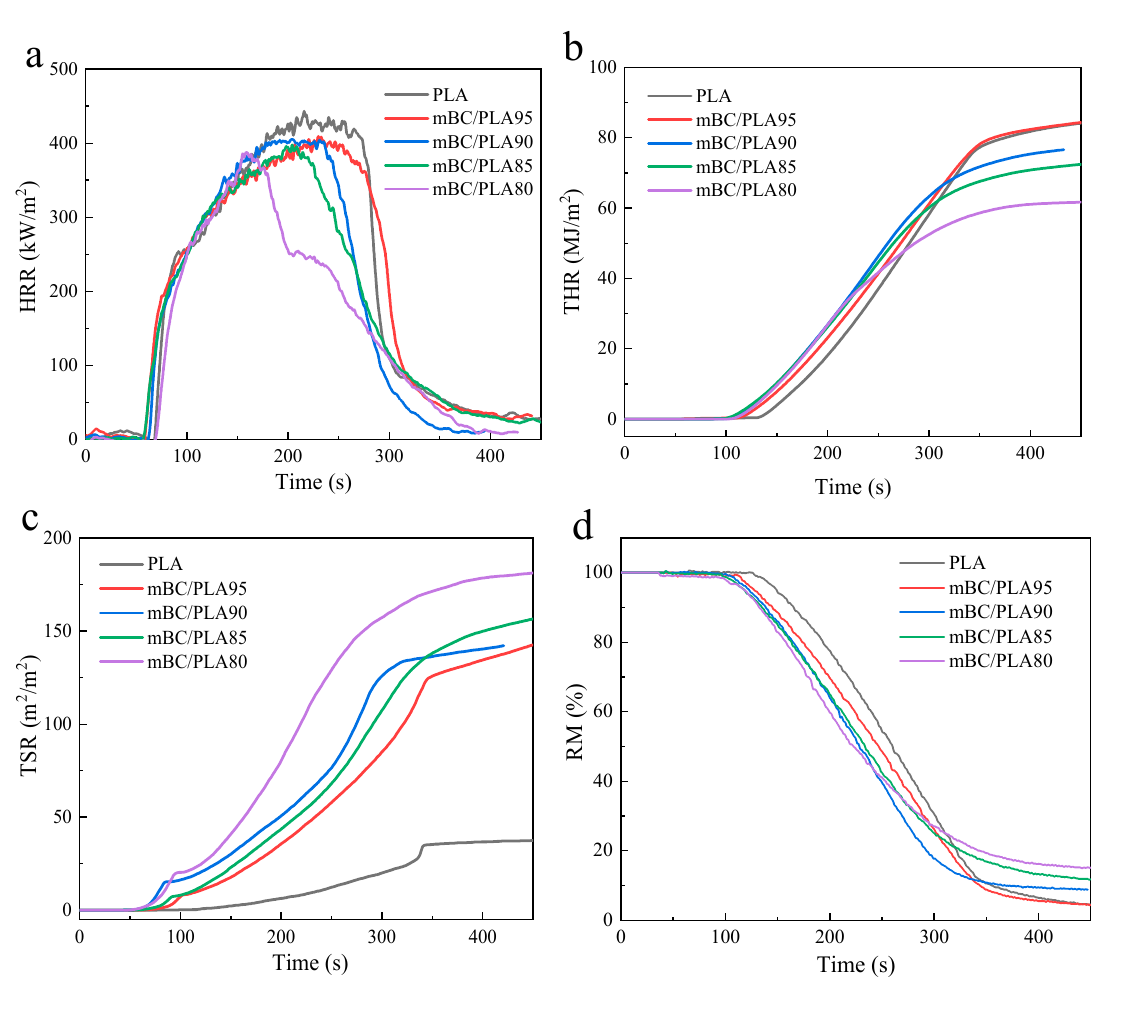
Figure 8. Cone analysis of PLA composites with an external heat flux of 35 kW/m 2 : HRR ( a ); THR ( b ); TSR ( c ); RM ( d